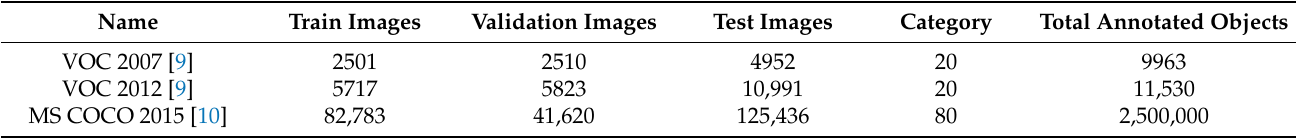
Figure 3. Some object detection examples in Pascal VOC ( upper ) and MS COCO ( lower ). Table 1. Dataset statistics of PASCAL Visual Object Classes (VOC) & Microsoft Common Objects in COntext (MS COCO). Name Train Images Validation Images Test